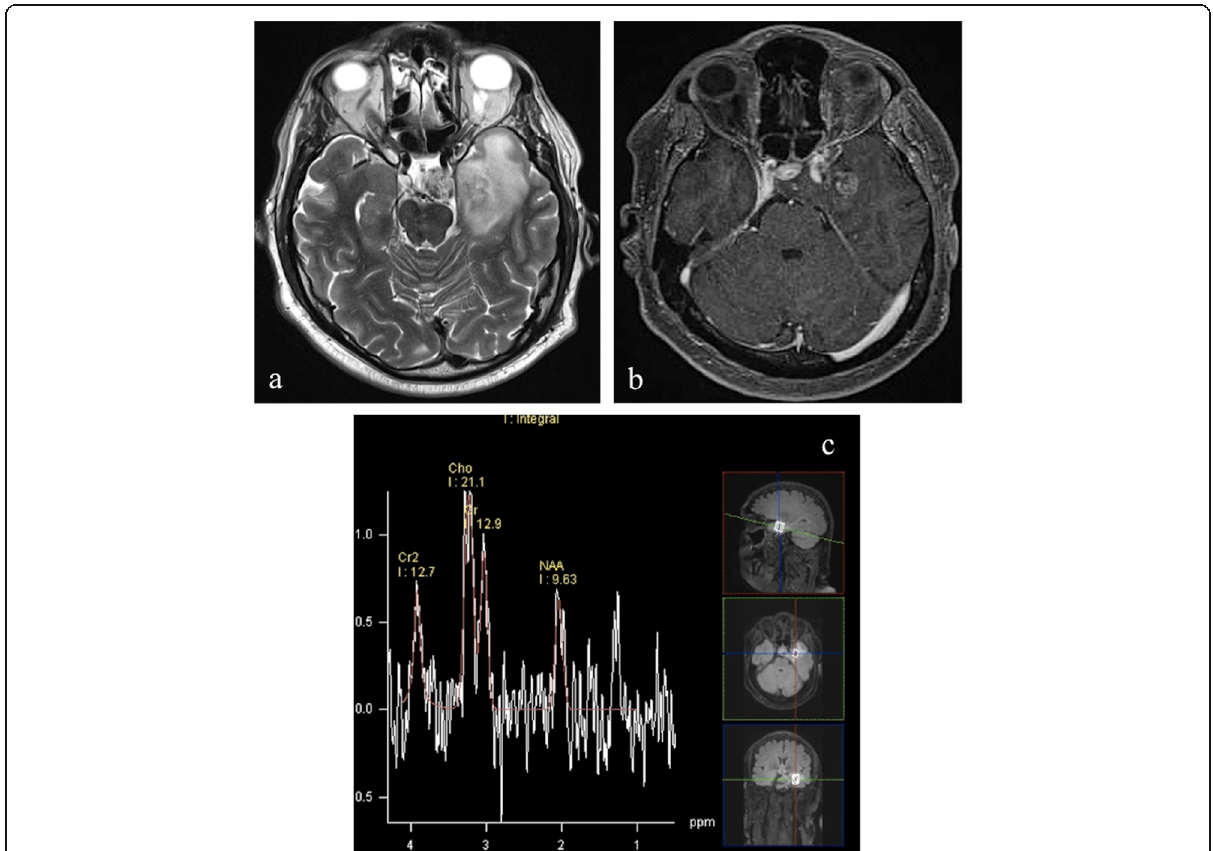
Fig. 9 MRI performed 10 months after 74 Gy proton-beam therapy in the same patient of Fig. 3, who previously underwent subtotal surgical resection of clival chordoma. Axial T2-weighted image ( a ) shows hyperintensy involving subcortical white matter and gray matter in left polar and mesial temporal regions right adjacent to clival structures. Axial post-contrast T1-weighted image ( b ) reveals the presence of a round-shaped contrast-enhancing lesion within the hyperintense area. Multi-voxel MRS ( c ) shows a choline (Cho) peak and an increase/inversion of choline/N- acetylaspartate (Cho/NAA) ratio, which may reflect inflammatory cells infiltrate in early brain